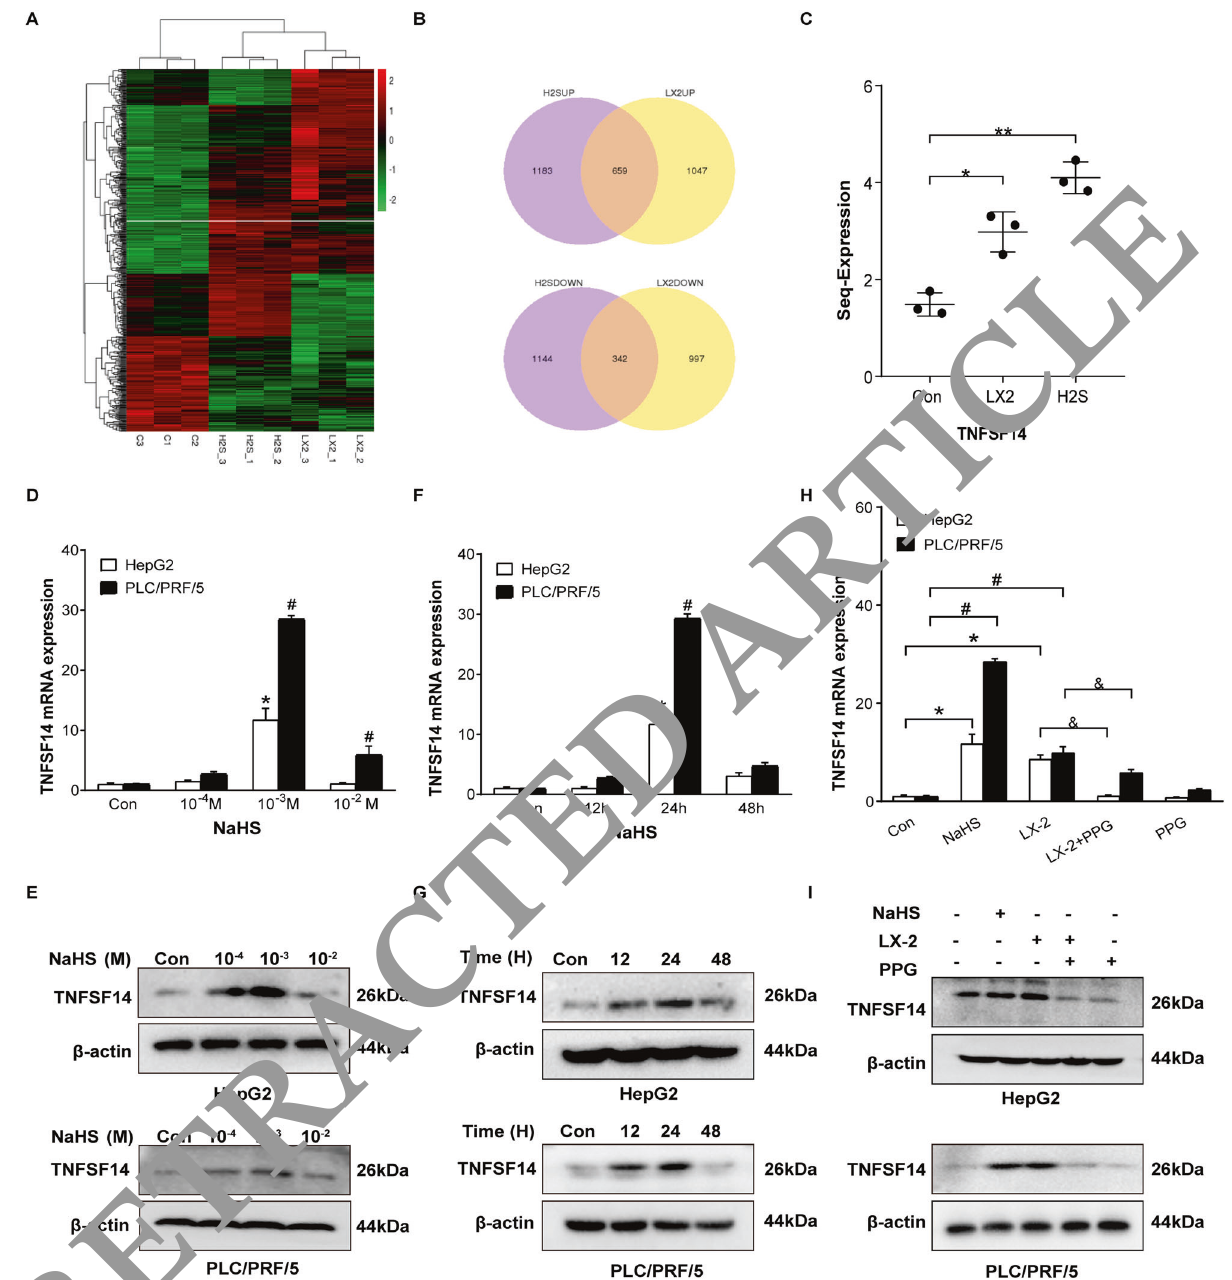
in HepG2 cells treated with NaHS and co-cultured with LX-2 cells. D RT-qPCR and ( E ) Western blotting were performed to examine the effects of various concentrations of NaHS on expression of TNFSF14 gene in HepG2 and PLC/PRF/5 cells. F RT-qPCR and ( G ) Western blotting